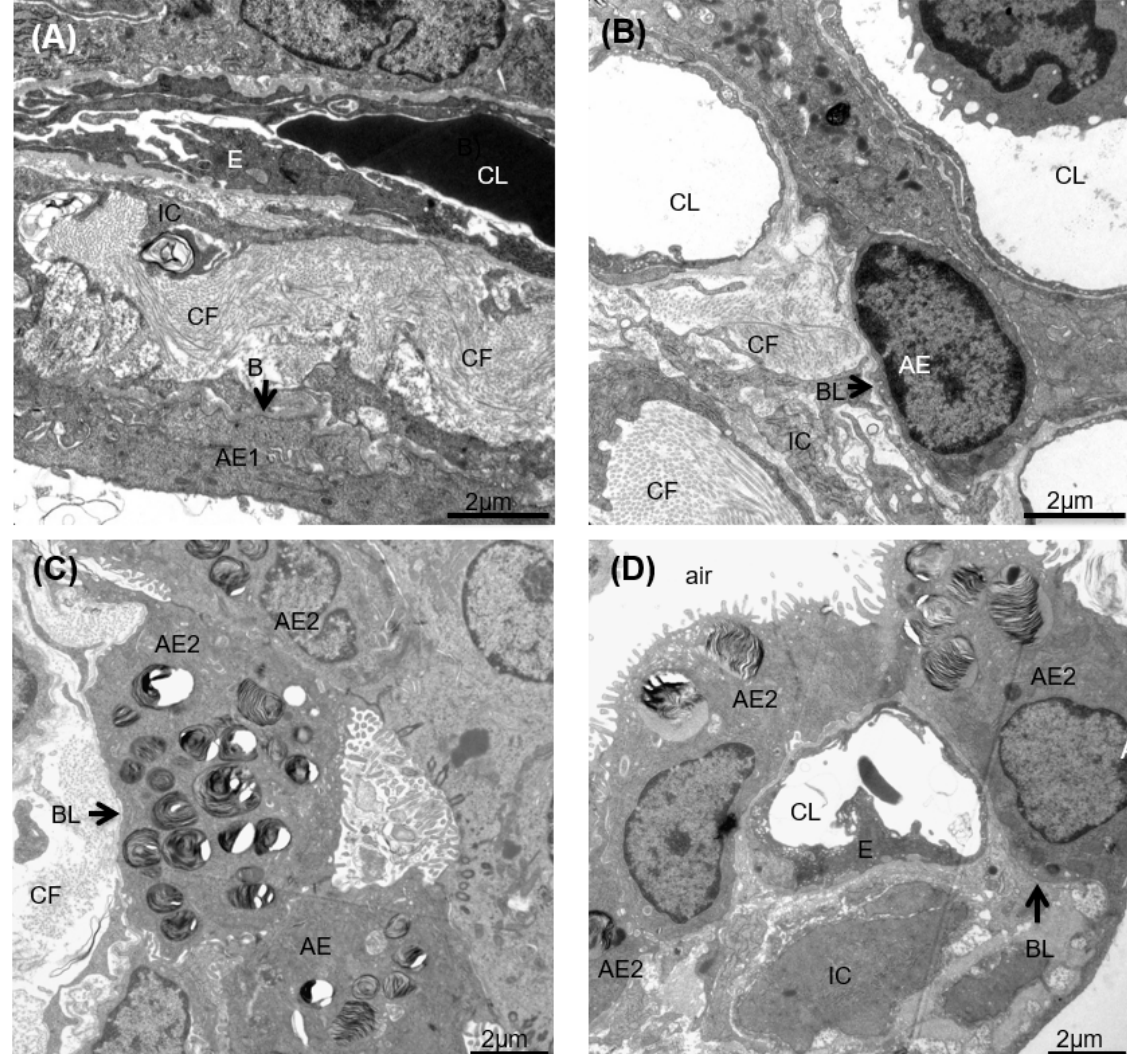
Figure 3. Effect of SDF-1 over expression on ultrastructure of lung. Electron micrograph of the bleomycin-injured lung treated with EV ( A , C ) and pSDF-1 ( B , D ). Accumulations of collagen fibrils (CF) could be seen in both groups. In addition, within the parenchymal tissue (= septal walls) alveolar epithelial cells (AE) could be distinguished from interstitial cells (IC), endothelial cells and the capillary lumen (CL). Hyperplasia of alveolar epithelial type II cells (AE2) could be identified in C and D. The alveolar epithelium covers the basal lamina (BL). These structures were further quantified in terms of their total volume within lung parenchyma using design-based stereology. Further abbreviations: E: endothelium; AE: alveolar epithelium.